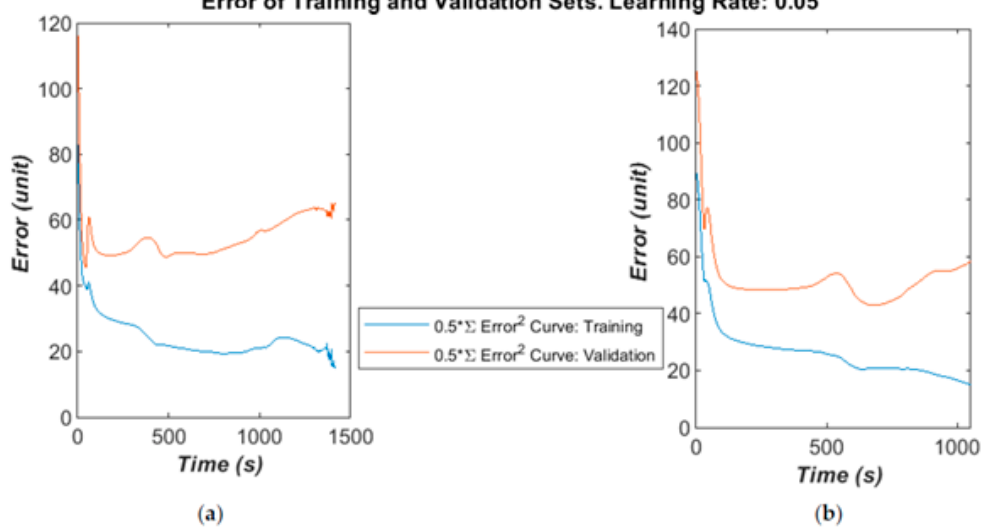
Figure 11. ( a ) Extended training and validation dataset’s error diverging. ( b ) Validation error increases in the late stage.